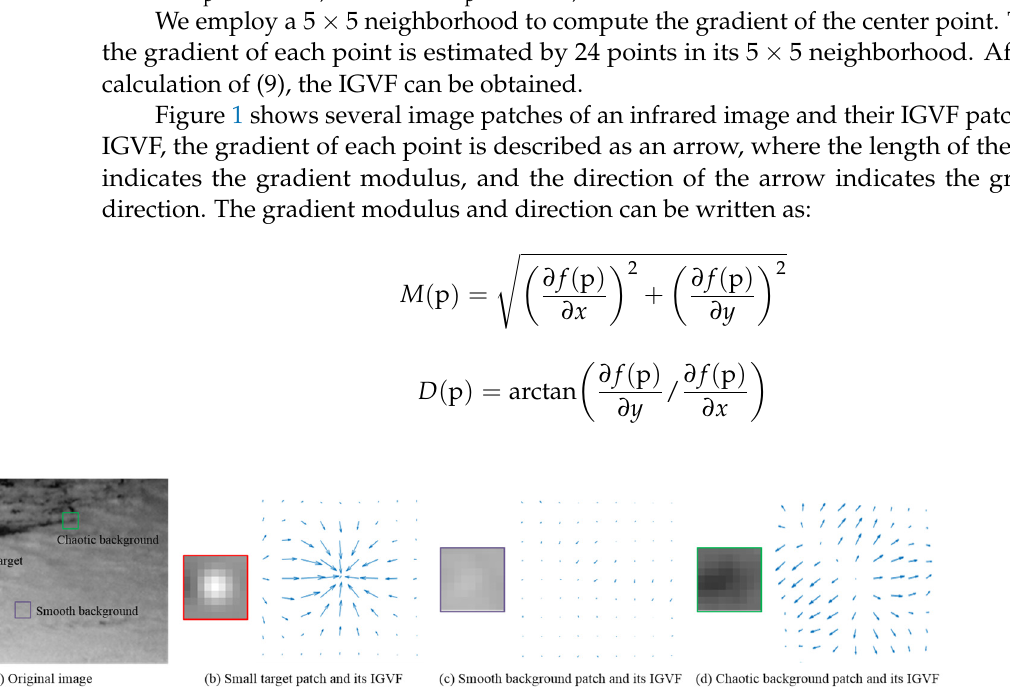
Figure 1. Several patches of an infrared image.